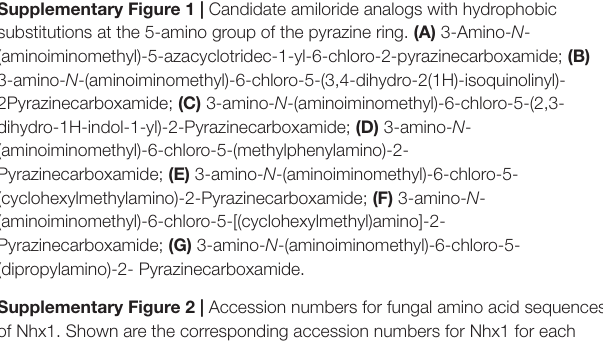
FigTree version 1.4.0 4 . Accession numbers are provided in Supplementary Figure 2